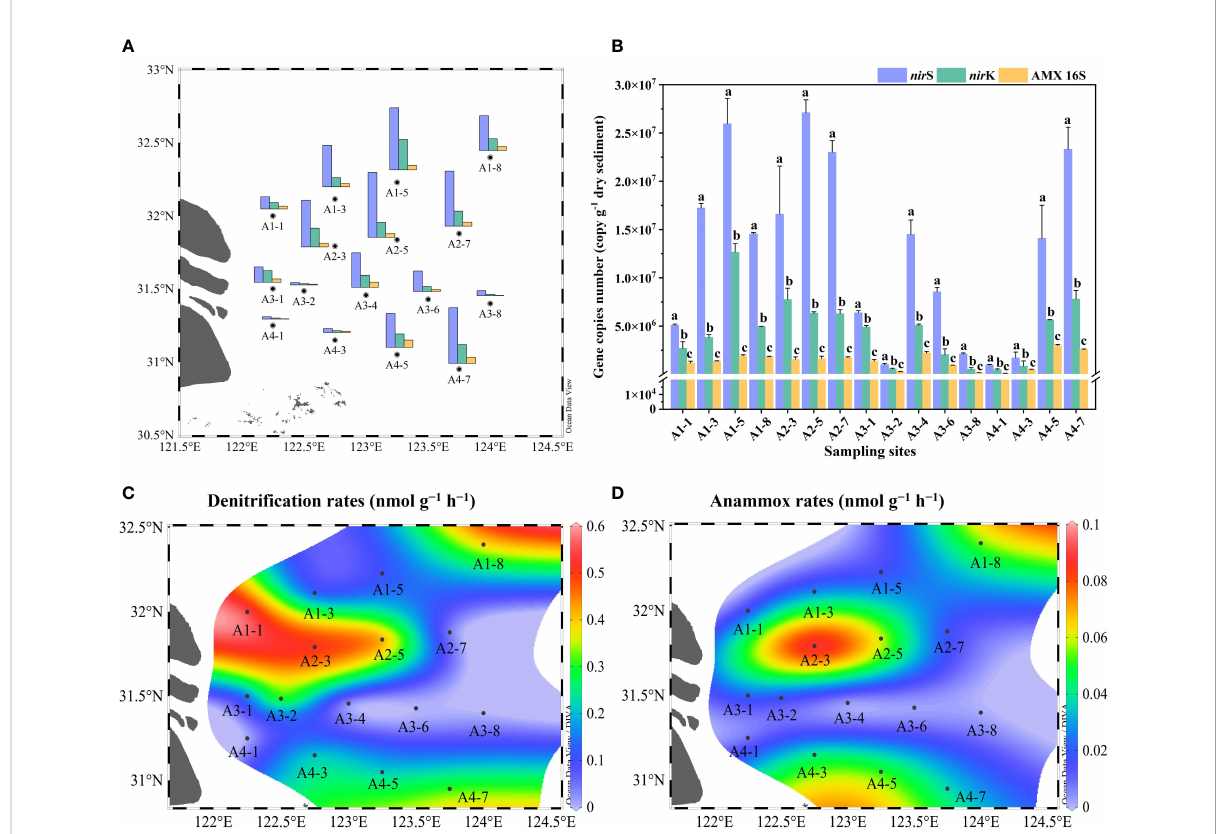
FIGURE 3 (A) Spatial distributions of gene abundances in the Yangtze Estuary and the adjacent sea; (B) Gene copies numbers of nir S, nir K and 16S rRNA. Error bars in the column represented the standard deviations of the triplicate qPCR reactions, and different letters indicated a signi fi cant difference between gene abundances in the same sampling sites ( p < 0.05); (C, D) Denitri fi cation and anammox